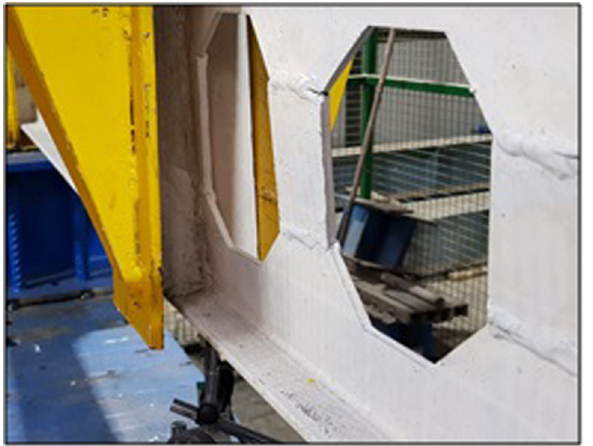
Figure 15: Failure model of TCB CBN - 3.